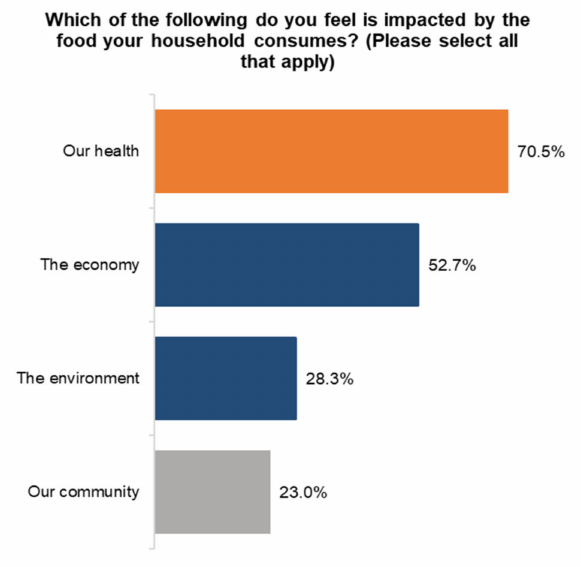
Figure 2. Influencing